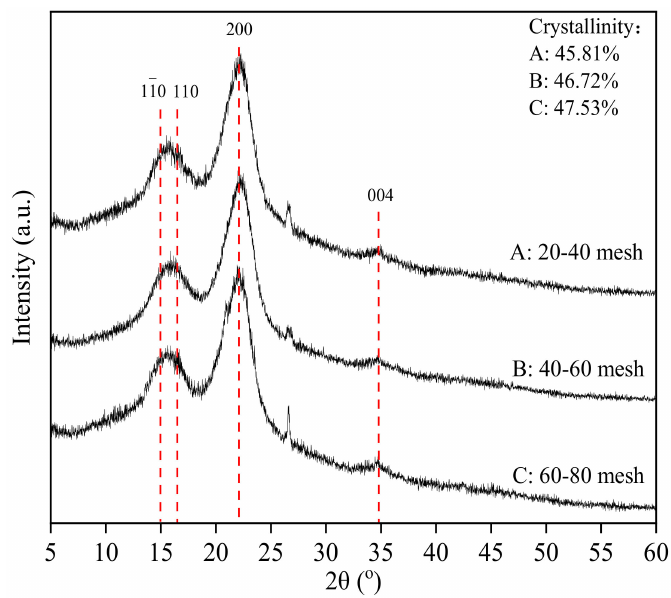
Figure 3. XRD patterns of the thread rolled samples with various meshes.